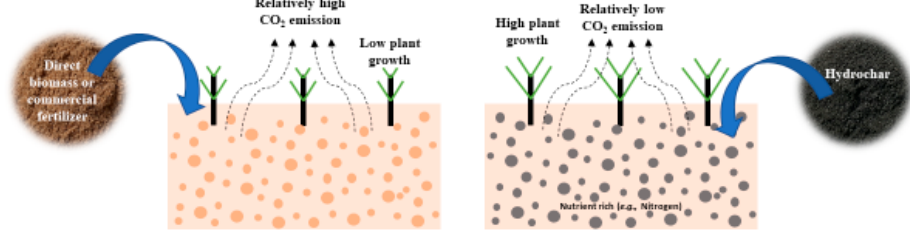
Figure 6. Hydrochar as soil amendment and carbon sequestration application.